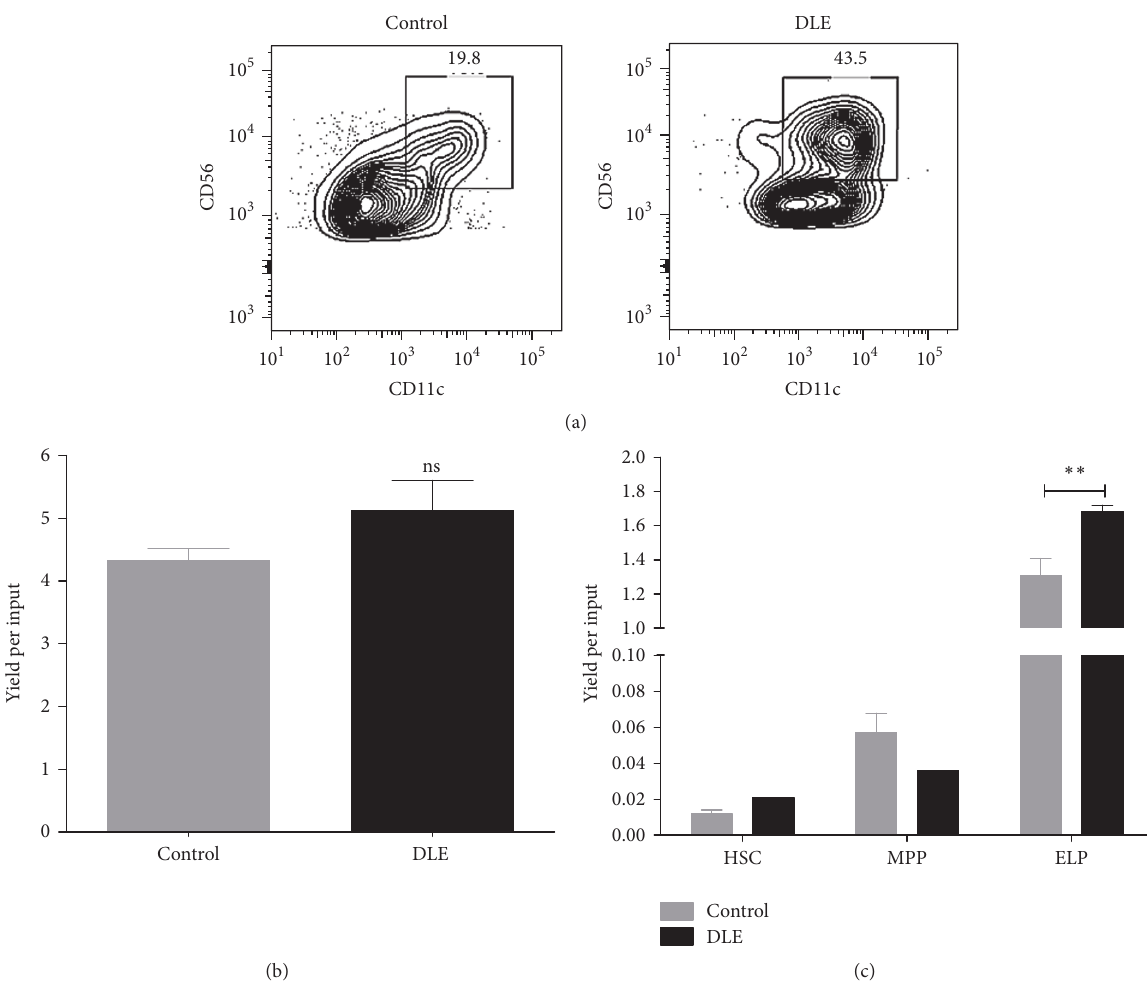
Figure 2: CD56 + CD11c + NK-like cells expeditiously develop from early lymphoid progenitors upon DLE stimulation. Upon 24 hours of DLE Transferon stimulation, the whole fraction of CD34 + cells (a and b) or purified primitive cells, including hematopoietic stem cells (HSC), multipotent progenitors (MPP), and early lymphoid progenitors (ELP) (a), were cocultured with MS-5 stromal cells for 30 days under lymphoid lineage conditions. CD56 + CD11c + NK-like cell production was investigated by flow cytometry and reported as cell frequencies (a) or yield per input progenitor (b and c). For comparison, unstimulated cultures were considered as control conditions. DLE, dialyzable leukocyte extracts Transferon. ∗∗ 𝑃 < 0.01